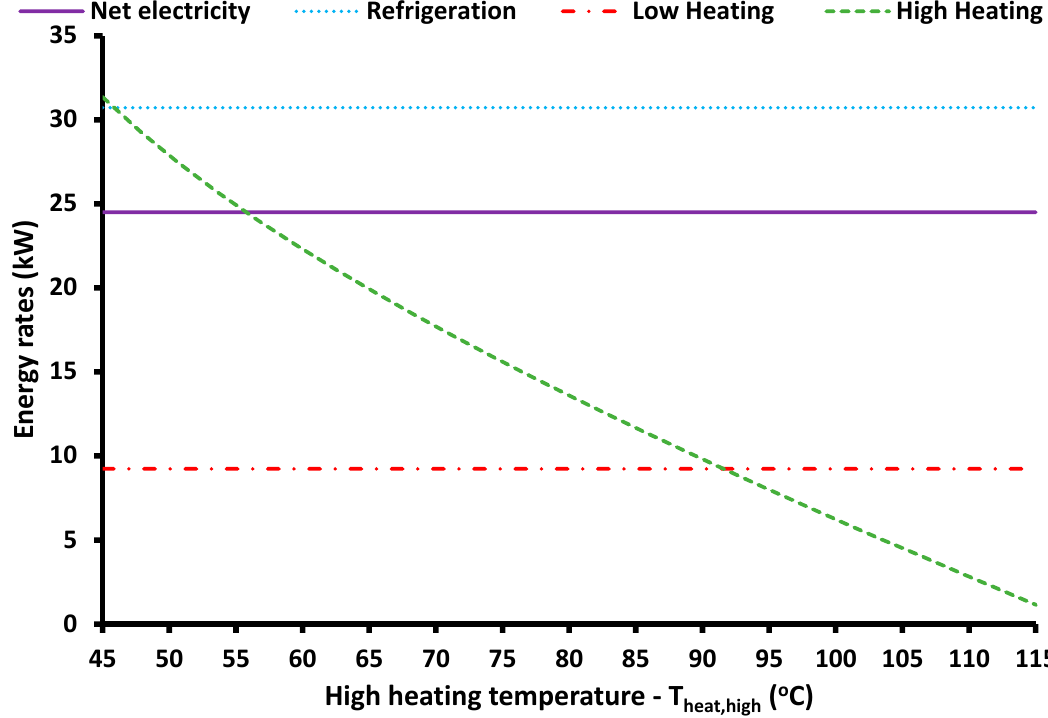
Figure 15. Energy and exergy efficiencies for different values of the heat rejection temperature.